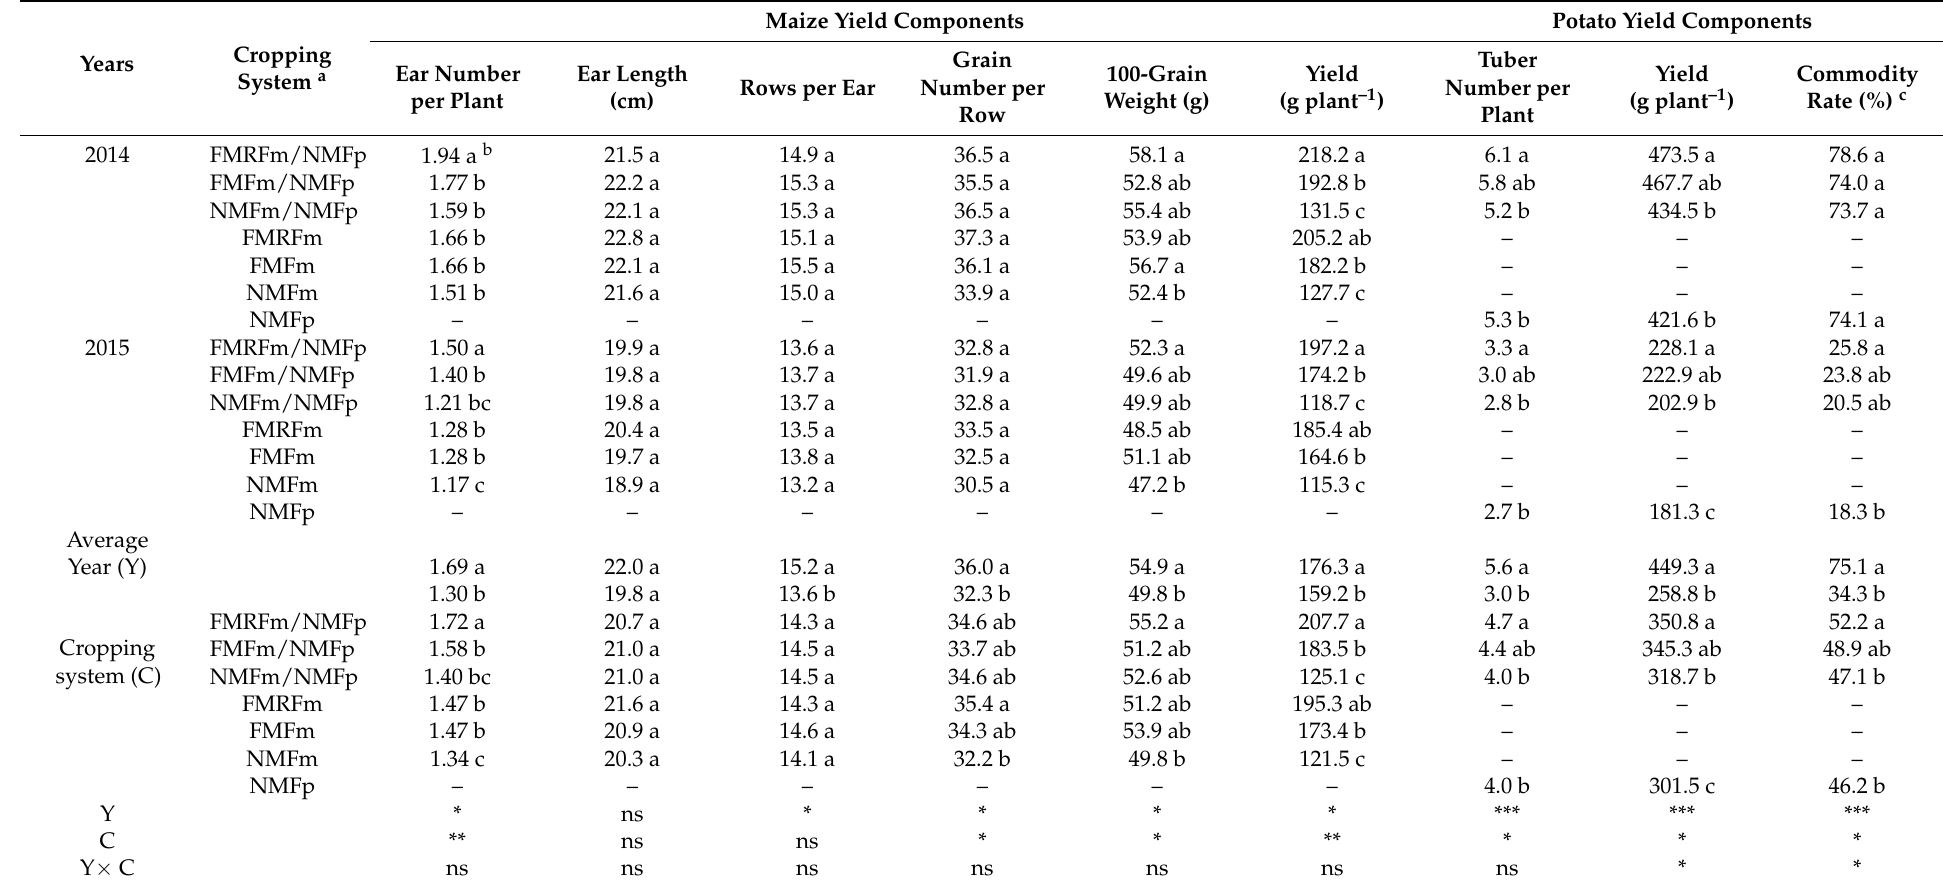
Table 1. Average grain yield and yield components of maize, tuber number, yield, and commodity rate of potato under different planting systems during 2014–2015.